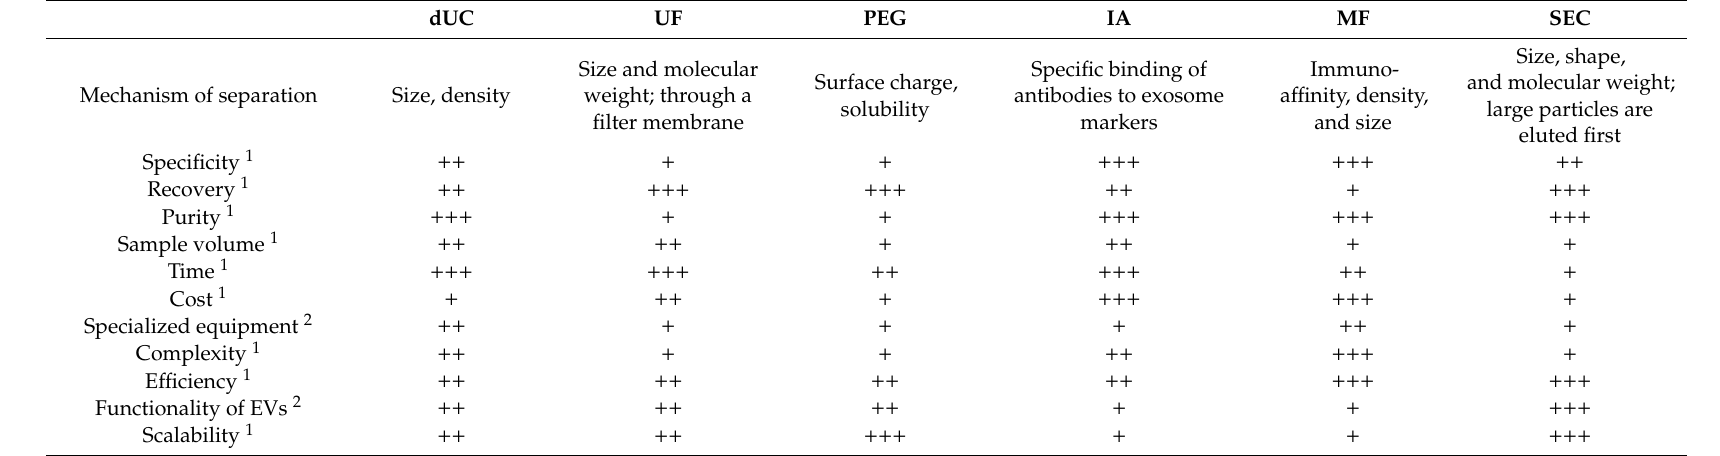
Table 1. Summary of di ff erent exosome isolation methods. To summarize the aforementioned isolation methods, we used a relative scaling to compare each factor listed: +++ (high), ++ (intermediate), or + (low), and in the case that grading was not applicable, we used a yes or no equivalence. Specificity : ability to separate exosomes; recovery : the amount of exosome (exosomal yield); purity : ability to separate exosomes with little contamination; sample volume : the amount of sample needed; time : ability to finish the processing in a short amount of time; cost : amount of money needed to perform the procedure; specialized equipment : need for expensive equipment; complexity : di ffi cult to follow and need for training before use; e ffi ciency : high quality sample processing; functionality of exosomes : ability to use the exosomes for functional studies without changing their e ffi cacy; scalability : ability to process a large amount of sample without overly increasing time, cost, or personnel needed. dUC: di ff erential ultracentrifugation, UF: ultrafiltration, PEG: poly-ethylene glycol-based precipitation, IA: immunoa ffi nity